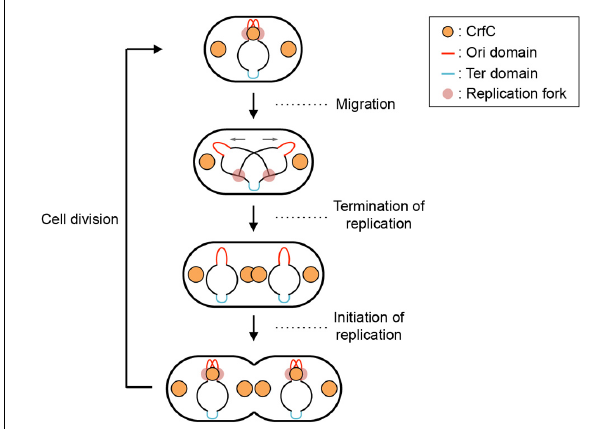
FIGURE 1 | Subcellular localization pattern of CrfC. Schematic illustrations of CrfC when cells are grown at 25 ◦ C in M9glu-caa medium. Replication intermediates and subcellular CrfC localization are shown (Ozaki et al., 2013). Sister replication forks are transiently colocalized after the initiation of replication and then CrfC colocalizes with nascent DNA regions at mid-cell. CrfC oligomers bind to the β clamp molecules of the DNA polymerase III holoenzyme, and CrfC molecules localize at cell pole-proximal loci throughout the cell cycle. In addition, prior to cell division, new CrfC foci are produced at mid-cell that will reside at cell pole-proximal loci after cell division (Ozaki et al., 2013).